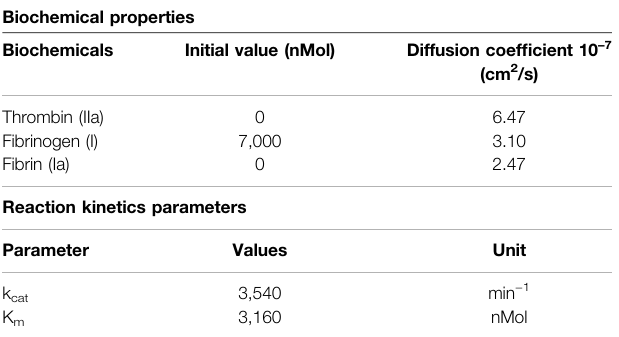
TABLE 1 | Biochemical properties and values used for the reaction kinetics [18].